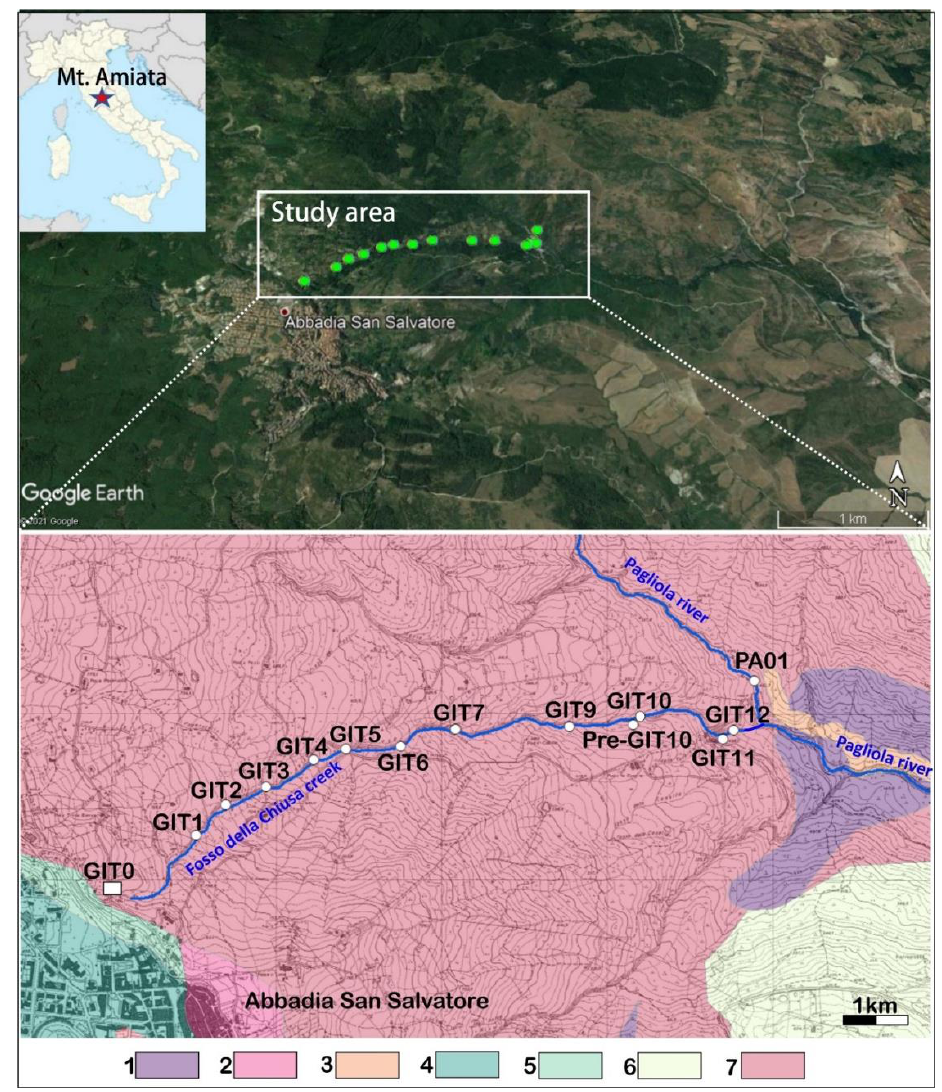
Figure 1. Location of the Mt. Amiata area and the Fosso della Chiusa creek (above) along with the schematic geological map (below) (modified from the Geological Database of Regione Toscana: http://www502.regione.toscana.it/geoscopio/geologia.html#, accessed on 4 June 2021, in which the IDs of the sampling sites are reported. 1, landslide; 2, detritus; 3, recent and present alluvial deposits (Holocene); 4, eluvial and colluvial deposits (Holocene); 5, rhyo-dacitic volcanics (Pleistocene); 6, (basal olistostrome) dark-greyish clays with blocks of marly limestone, calcareous microbreccia, and sandstone (Upper Oligocene); 7, Ligurian domain: clays and marls with limestone, marly limestones, sandstone, and calcarenite, occasionally intercalated with sedimentary breccia consisting of green rocks, jaspers, and limestones (Paleocene-Lower Cretaceous).